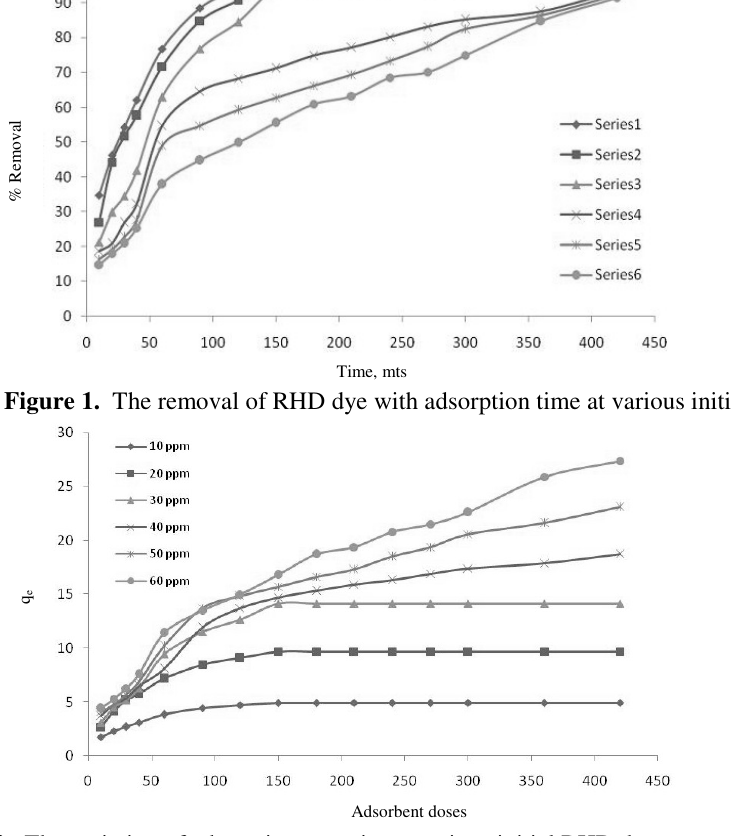
Figure 2. The variation of adsorption capacity at various initial RHD dye